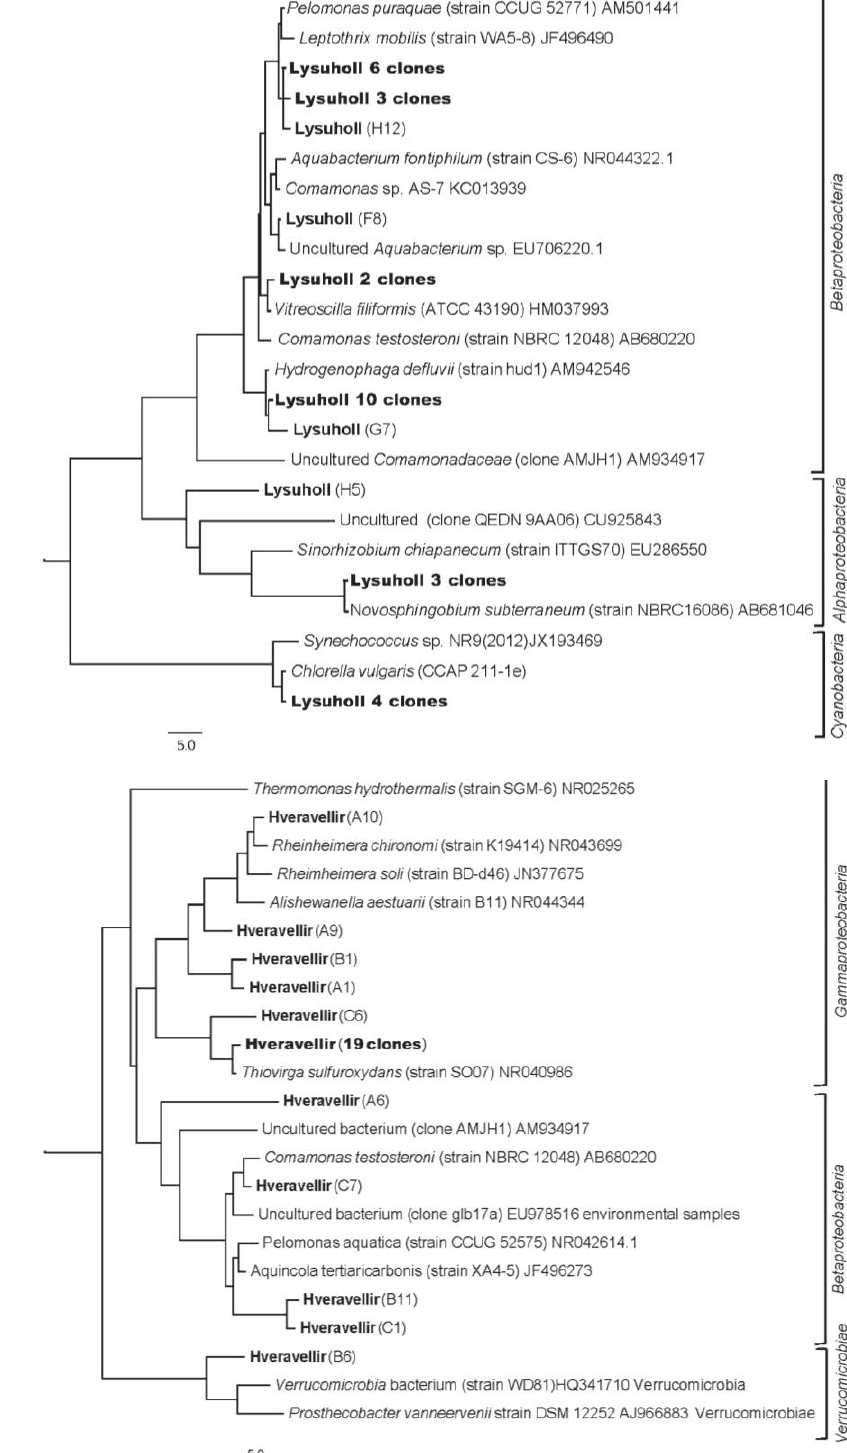
Figure 2. ( a ) Phylogenetic tree based on neighbor-joining analysis of the 16S rRNA gene sequences of 32 bacterial clones from Lýsuhólslaug; ( b ) 29 bacterial clones from Hveravellir; ( c ) 32 bacterial clones from Landmannalaugar. Aquifex bacteria were used as an outgroup in all the trees. The scale bar represents the expected % of substitutions per nucleotide position. All OTUs from samples are marked in bold for each clone and their numbers if more than one. The GenBank accession numbers of reference sequences are given for each